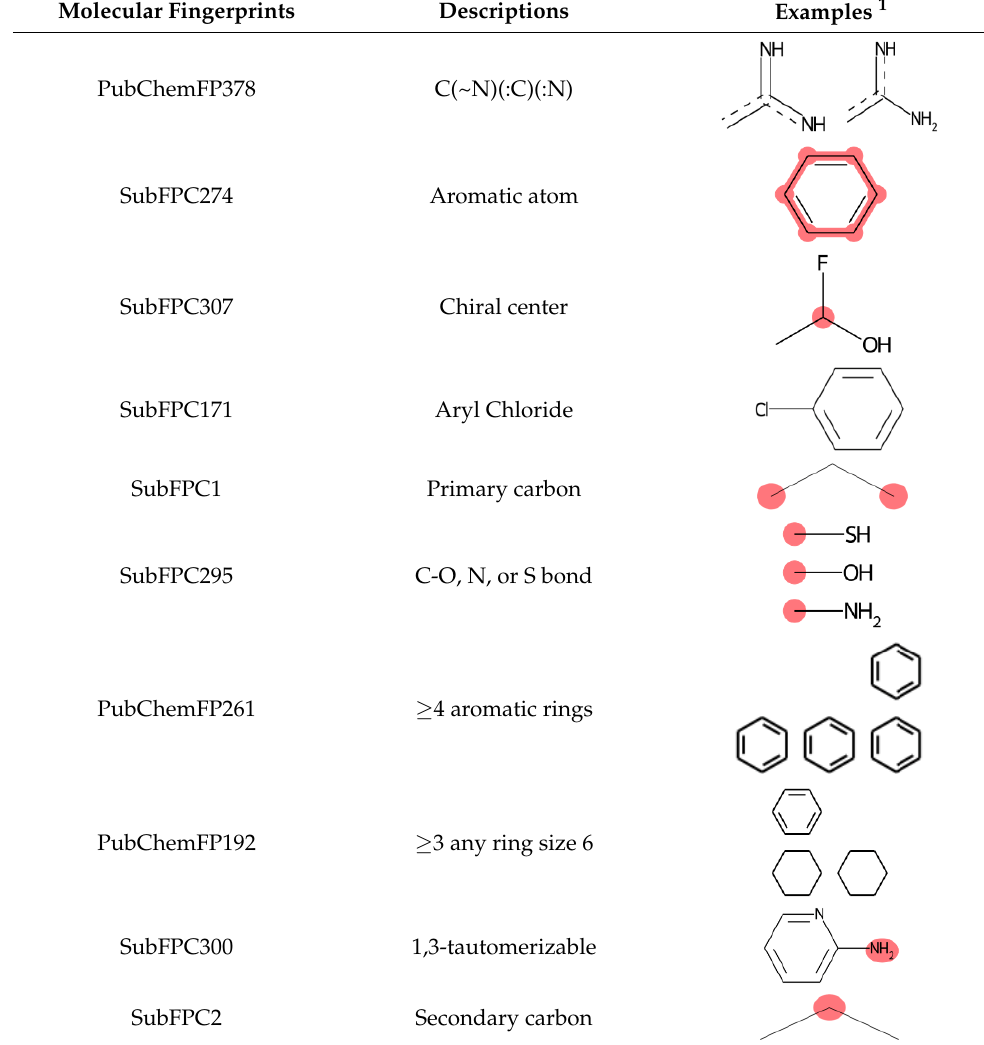
Table 1. List of similar importance molecular fingerprints extracted from classification and regression models using the SHAP algorithm.